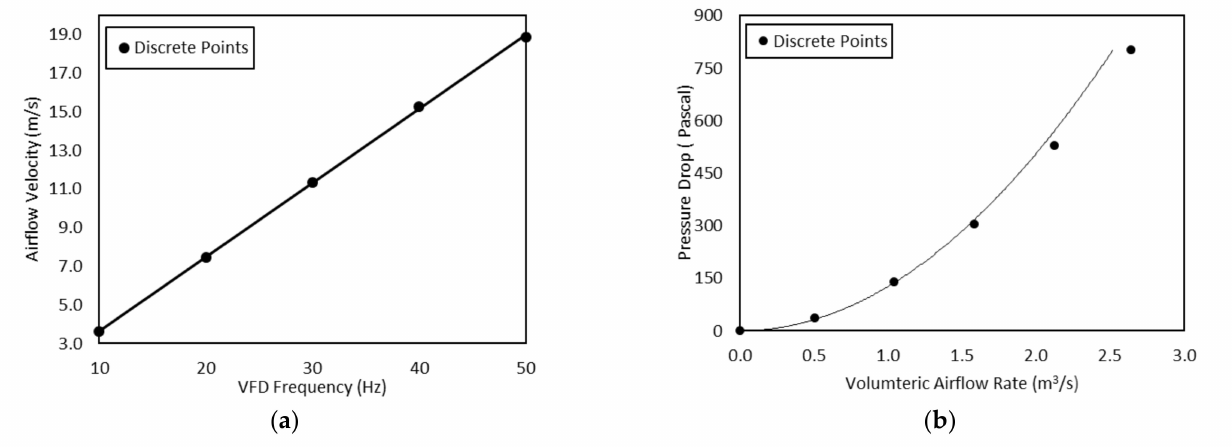
Figure 2. ( a ) Linear dependence of airflow speed on the VFD frequency; ( b ) quadratic dependence of total pressure drop on the airflow through the